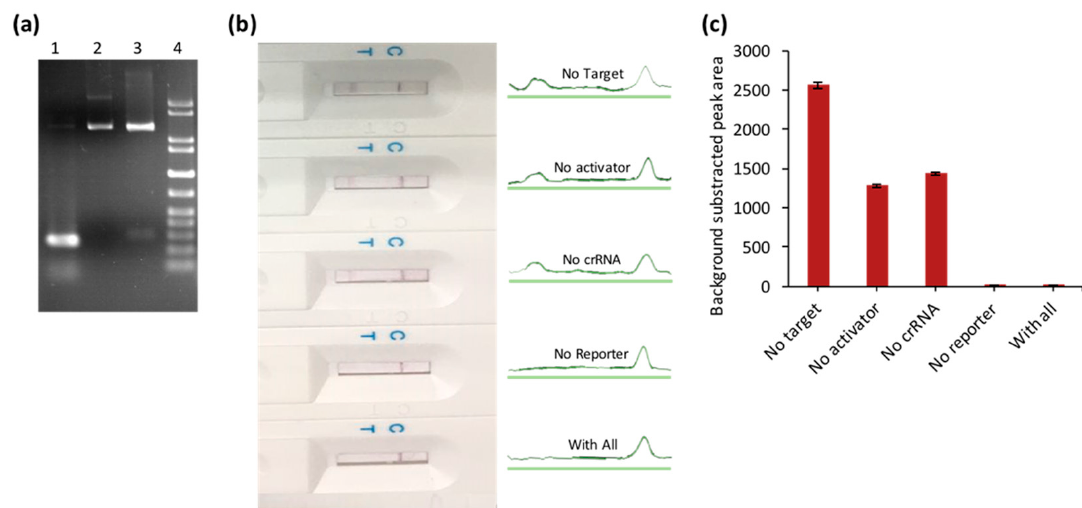
Figure 3. The feasibility assay of CRISPR/Cas–LFB assay using a recombinant plasmid. ( a ) Gel electrophoresis of the PCR-amplified 270 bp of African swine fever virus (ASFV)-specific sequence (1) cloning in pUC57 (2) and double digestion verification at BamHI / EcoRI enzyme site (3). ( b ) CRISPR/Cas–LFB reaction in the presence/absence of different reaction components showing test and control line signal intensities. ( c ) Bar chart of the LFB test lines in ( b ).